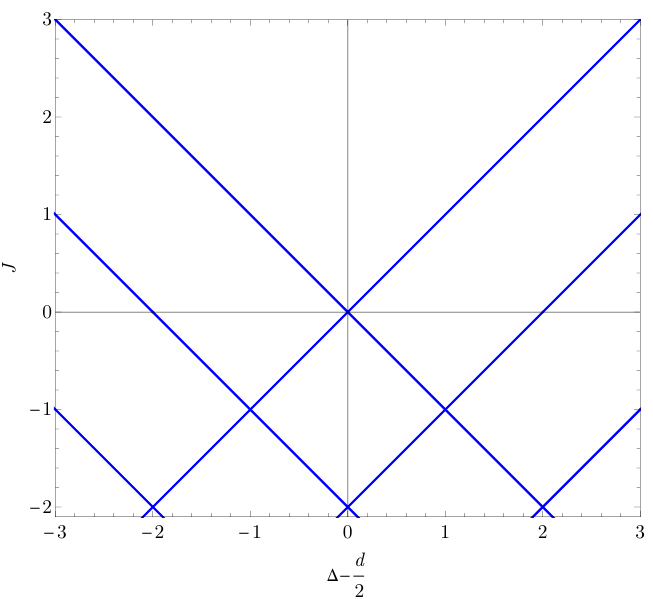
Figure 4. Chew-Frautschi plot of free theory in d = 4 after accounting for higher-twist trajectories and their shadows. This is a less naive version of figure 3. The full picture is expected to be more complex and is described in the main text (see also figures 5 and